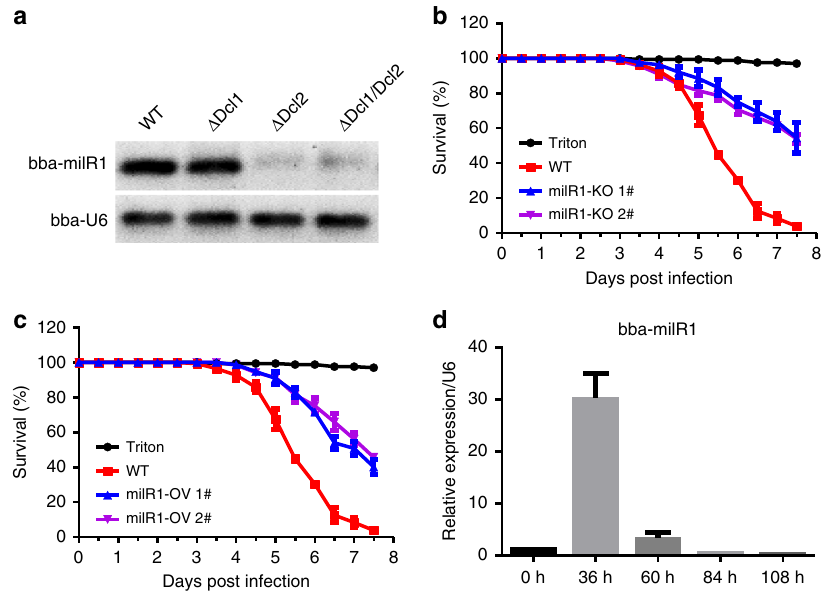
Fig. 1 Roles of B. bassiana bba-milR1 on fungal pathogenicity against mosquitoes. a bba-milR1 cannot be detected in B. bassiana Dicer2 deletion mutant ( Δ Dcl2) and Dicer1/Dicer2 double-mutant ( Δ Dcl1/Dcl2), as revealed by RT-PCR. RNA was extracted from fungal mycelium. b Survival of adult female A. stephensi mosquitoes infected with the wild-type (WT) ARSEF252 and two mutant strains milR1-KO 1# and milR1-KO 2# following topical application of a spore suspension (10 7 conidia/ml). Mosquitoes sprayed with sterile 0.01% Triton X-100 were used as a negative control (Triton). c Survival of female adult mosquitoes following topical application of a suspension of 10 7 conidia/ml of WT and two overexpression strains milR1-OV 1# and milR1-OV 2#. The statistical signi fi cance of survival curves was analyzed with the Log-rank test. d Expression of bba-milR1 during B. bassiana ARSEF252 infecting A. stephensi . RNA was extracted from fungus-infected mosquitoes. The B. bassiana U6 small nuclear RNA (U6) was used as an internal reference in qRT-PCR assays. The expression values are normalized to time 0. The data represent three biological repeats with three technical replicates and are shown as mean ±